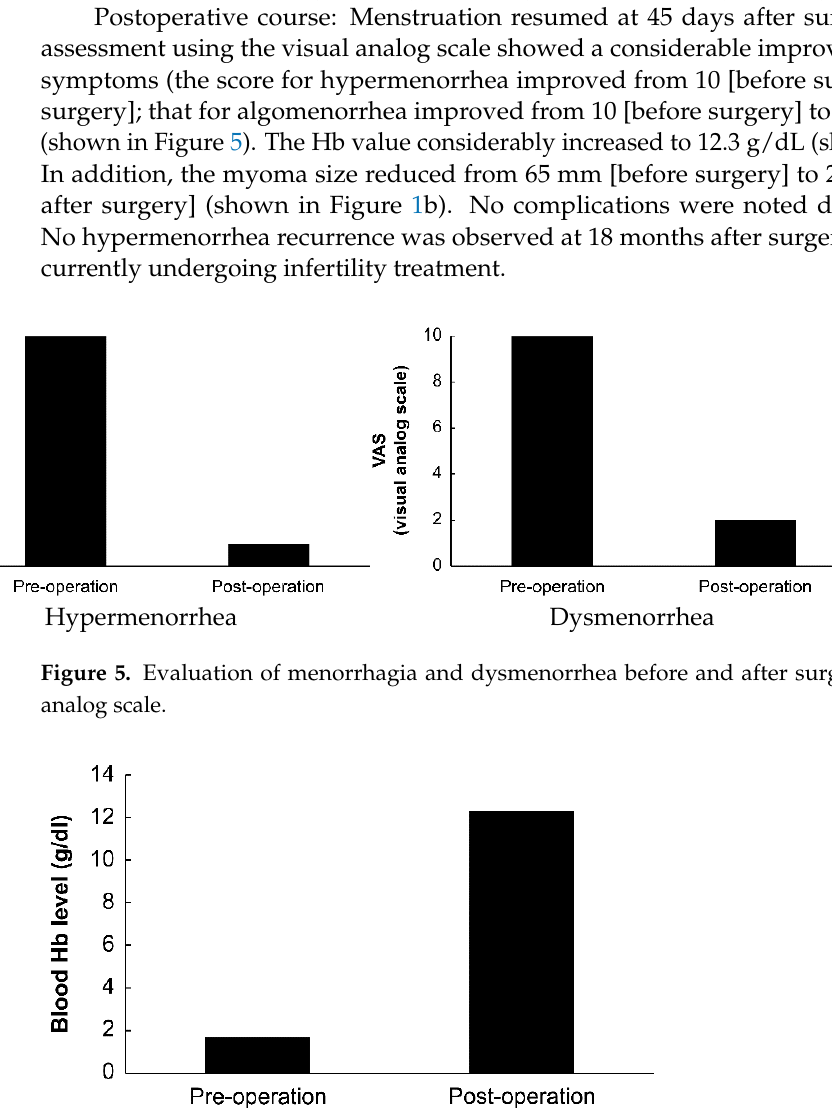
Figure 6. Changes in hemoglobin (Hb) levels.